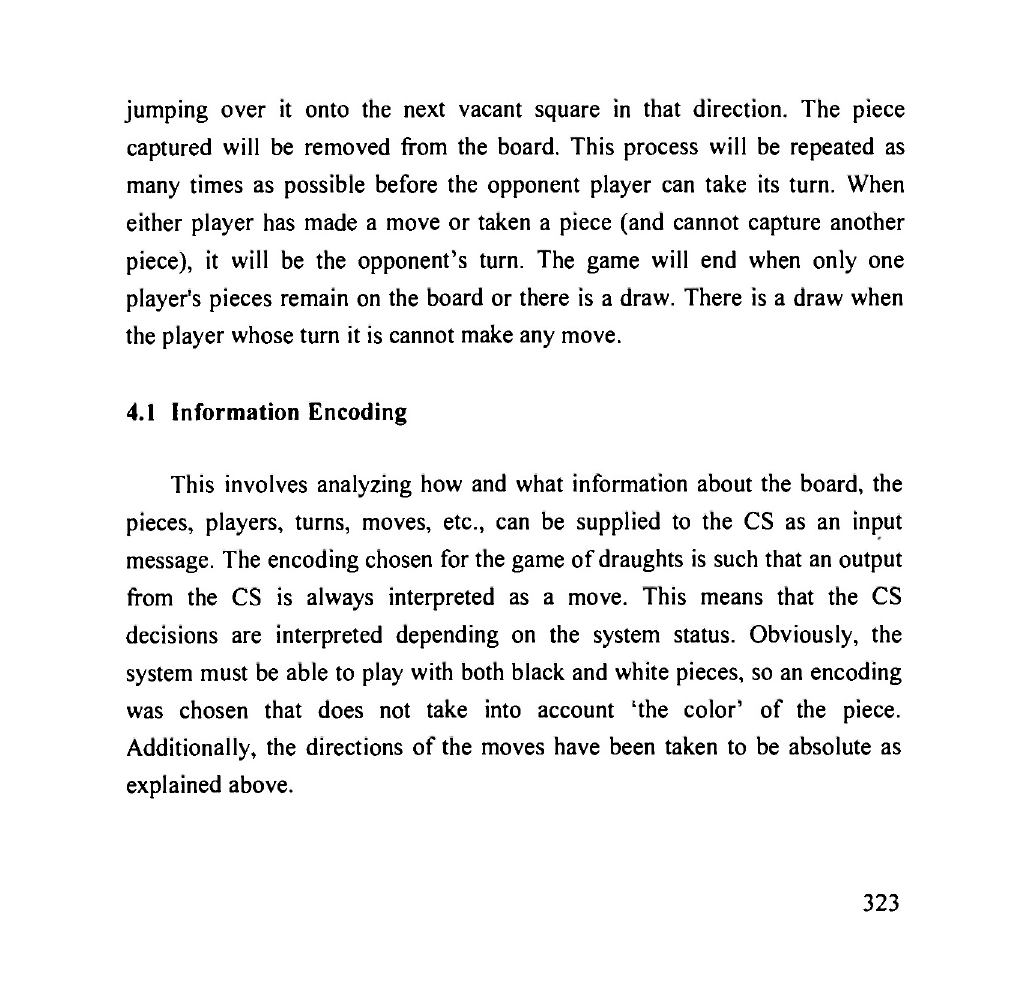
Fig. 2: Possible moves of pieces and kings on a board and definition of the directions of